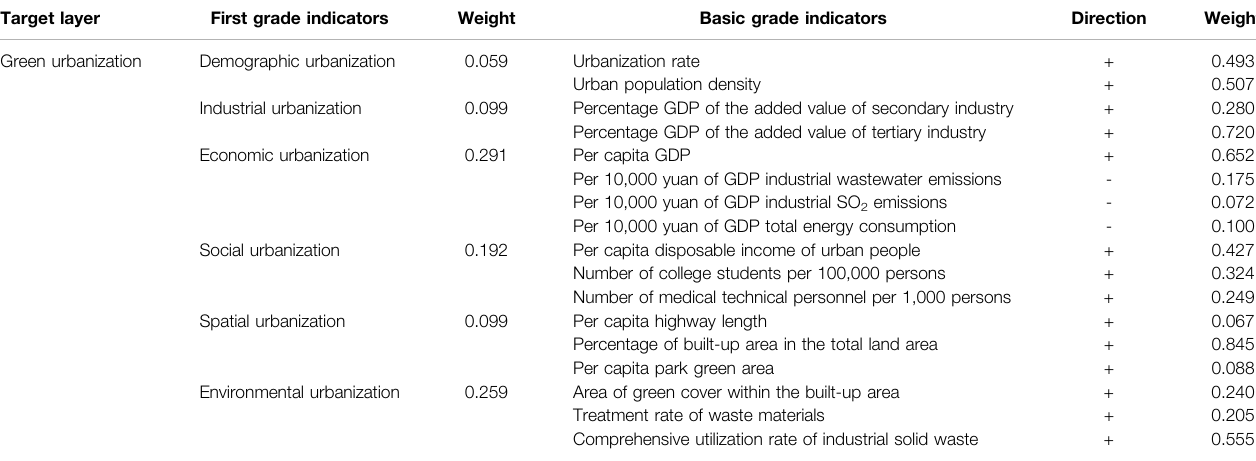
TABLE 2 | The evaluation indicator system and weights for assessing green